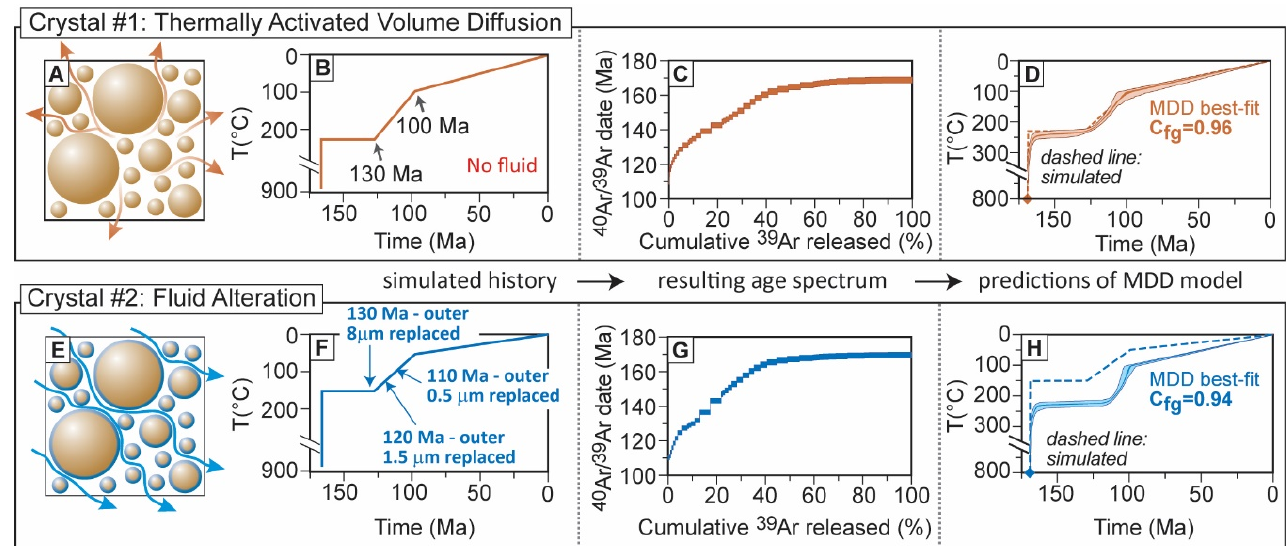
Figure 9. Forward modelling of Popov and Spikings (2020) [59] to test the ability of the Cfg parameter (Lovera et al., 2002) to compare laboratory and natural Ar degassing mechanisms, and thus the validity of MDD inversion to generate accurate t-T histories. All simulations assume that laboratory degassing occurs by volume diffusion, and only the mode of natural Ar loss is modified. ( A – D ) no fluid interaction during natural degassing; ( E – H ) fluid interaction driving dissolution-precipitation and Ar loss. Figures show forward modelled t-T paths and aqueous history ( B , F ), resultant age spectra ( C , G ) and best-fit t-T solutions generated by inversion using MDD modelling ( D , H ). In scenario with no fluid interaction a crystal with 3 non-interacting spherical domains with radii of 150, 50 and 16 microns occurring in proportions 1:5:150 have only lost 40 Ar by volume diffusion. The best fit t-T path obtained by MDD inversion yields a high degree of correlation (crystal #1; Cfg = 0.96) between the age spectrum and the log(r/ro) plot (not shown), and the modelled t-T path obtained by MDD inversion ( D ) closely matches the original t-T path ( B ). Similarly, we forward modelled a t-T path ( F ) with accompanying fluid assisted dissolution-precipitation that reset specific volumes of the three modelled domains at specific times (crystal #2). The best fit t-T path obtained by MDD inversion yields a Cfg of 0.94, although the t-T solution ( H ) does not accurately recreate the original t-T model ( F ). MDD theory would utilise the high degree of correlation to interpret the t-T paths obtained by MDD inversion in both cases, as accurate. Details are provided in Popov and Spikings (2020)